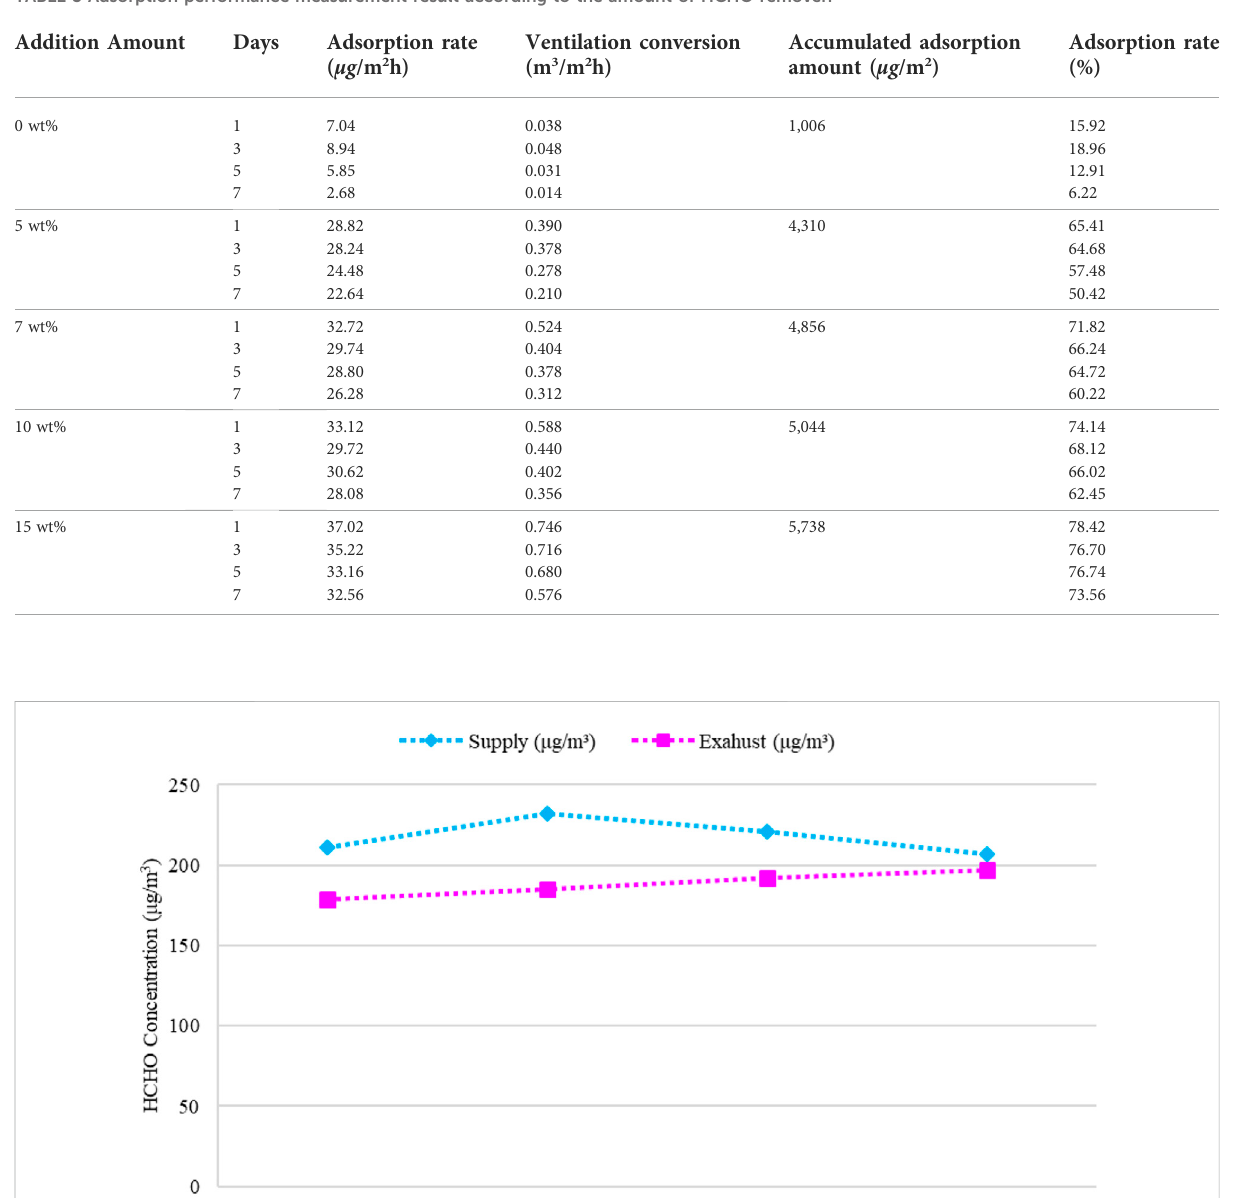
TABLE 5 Adsorption performance measurement result according to the amount of HCHO remover.